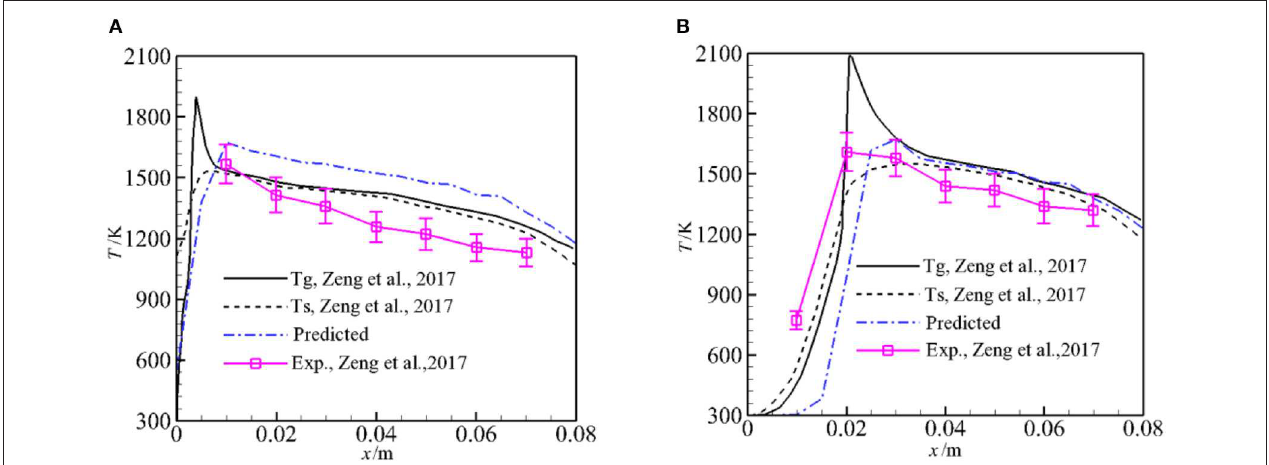
FIGURE 5 | Predicted temperatures for φ